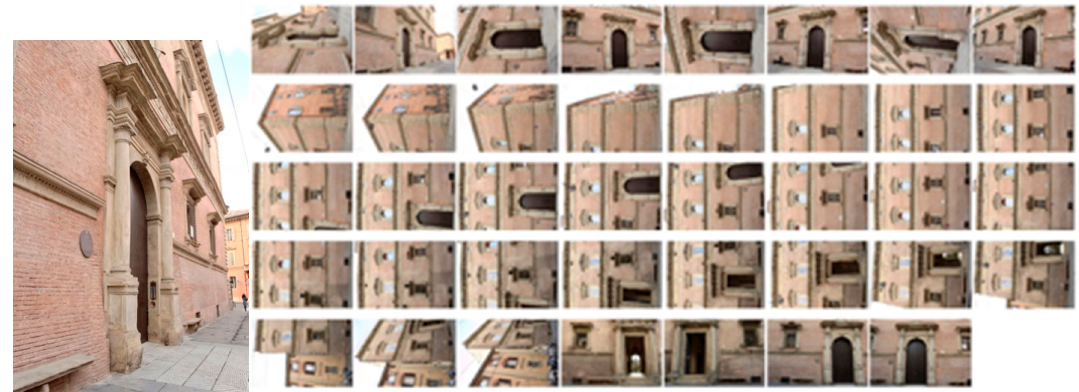
Figure 7. The building with portico dataset.